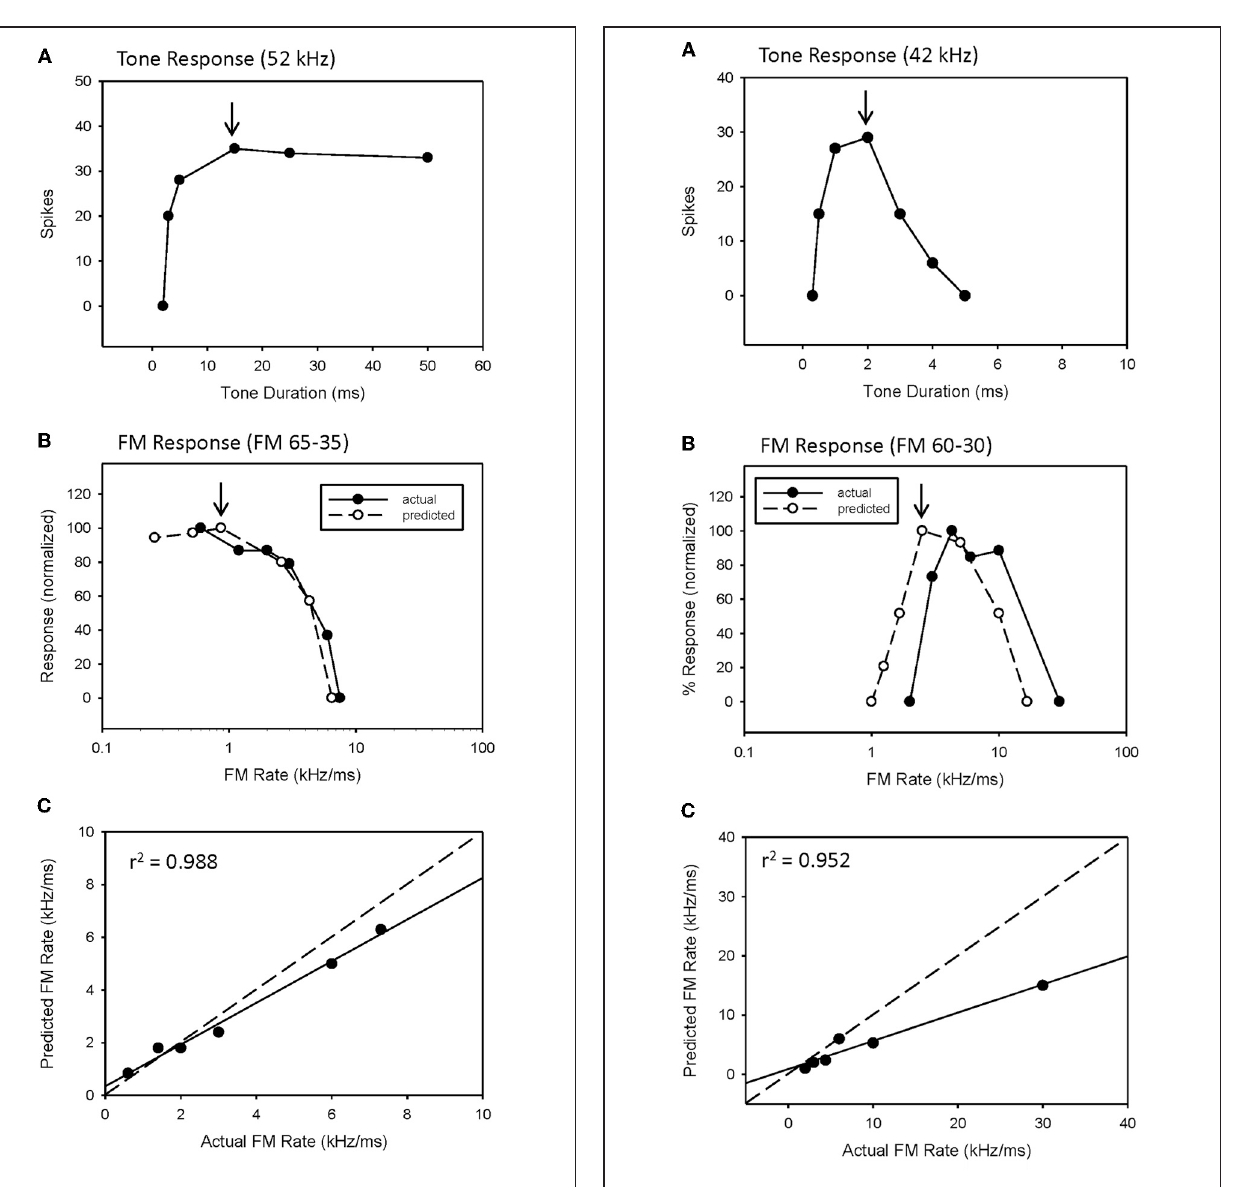
FIGURE 3 | The duration function of a bandpass duration-tuned neuron (A) that was predictive of a bandpass FM rate response (B) with a significant correlation (C) between predicted and actual FM rates